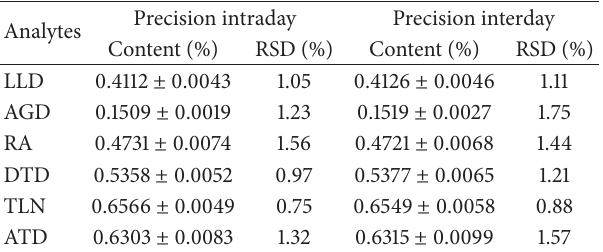
Table 4: Precision for the six active constituents (mean ± SD, 𝑛 = 6